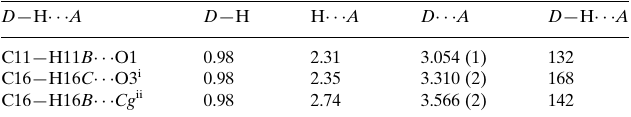
Hydrogen-bond geometry (A˚ , (cid:2)